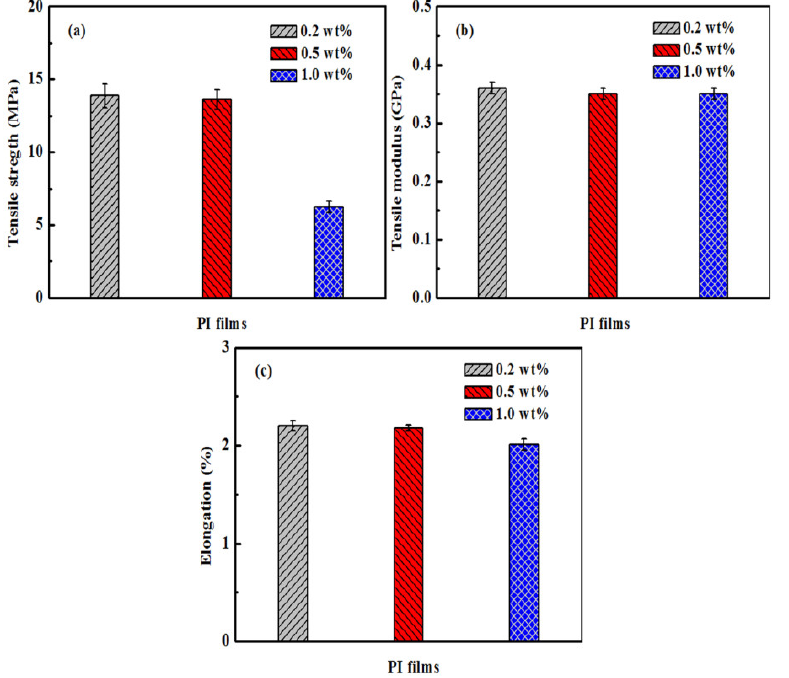
Figure 7. Tensile performance of the porous PI films: ( a ) tensile strength, ( b ) tensile modulus, ( c ) elongation at break.